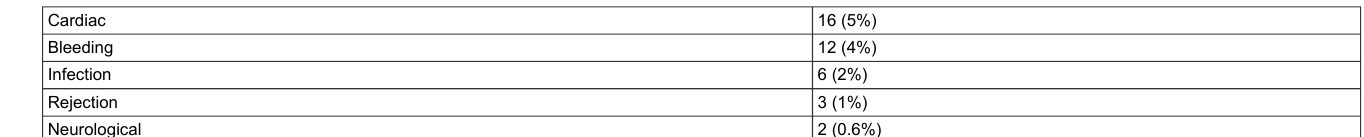
Table S3: Causes of death <3 months in the total cohort (n = 39).